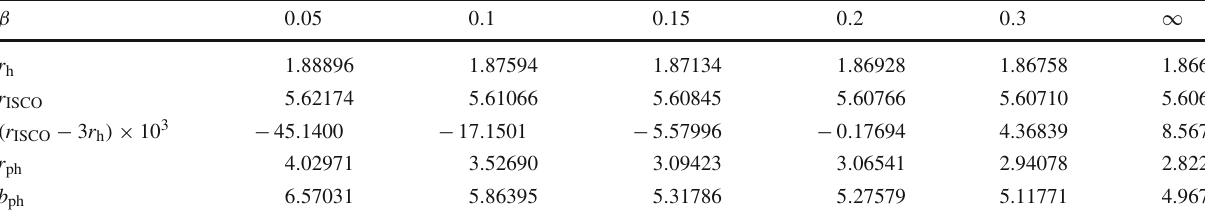
Table 2 Data of r h , r ISCO , r ph , and b ph for different β with fixed M = 1, P = 0 . 5